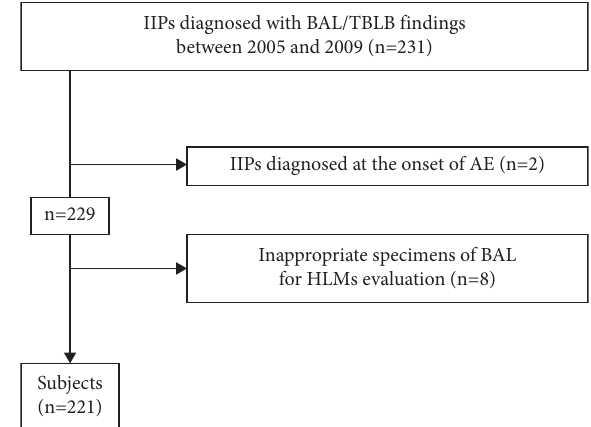
Figure 1: Flow chart of subject selection. Abbreviations: IIPs, idiopathic interstitial pneumonias; BAL, bronchoalveolar lavage; TBLB, transbronchial lung biopsy; AE, acute exacerbation; HLMs, hemosiderin-laden